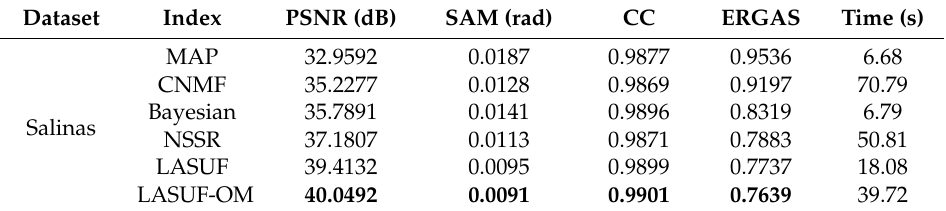
Table 1. Comparison of average statistical indexes of different methods of data